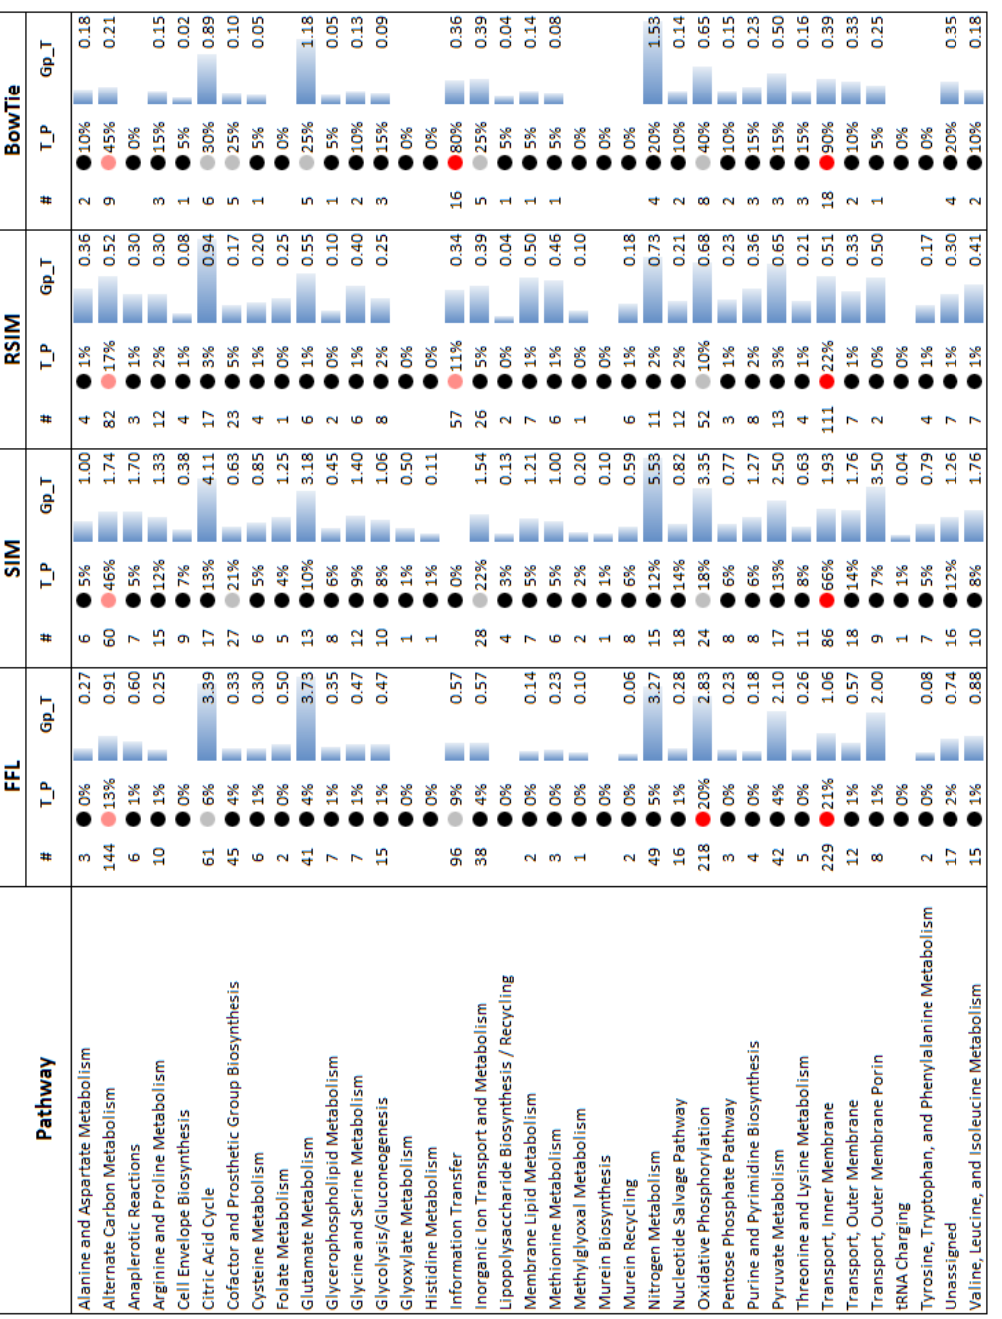
Table 2: Statistical evaluation of the occurrence of regulatory motifs per pathway. Abbreviations: # is the number of motifs of type T found in pathway P; T P is the relative frequency of a motif type T in pathway P ; and G P T is the frequency of genes from the pathway P (G P ) involved in motif type T (see section Network Analysis for details). The values of T P indicate the prevalence of motif type T in metabolic pathway P , while the values of G P T indicate the number of genes in pathway P that are affected by the regulation of motif type T